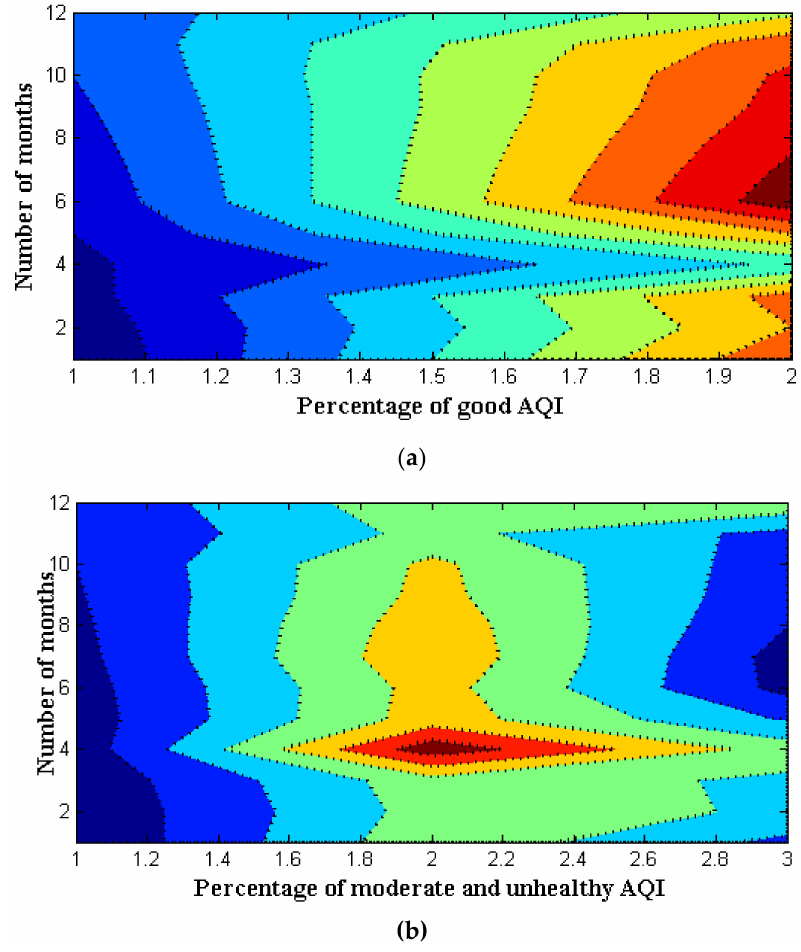
Figure 7. Month-based AQI: ( a ) Good state ( b ) Moderate and unhealthy state. The blue color map in Figure 7 represents the good state whereas the yellow and red indicates the moderate and unhealthy states of AQI values. Table 2. Year-based of AQI.